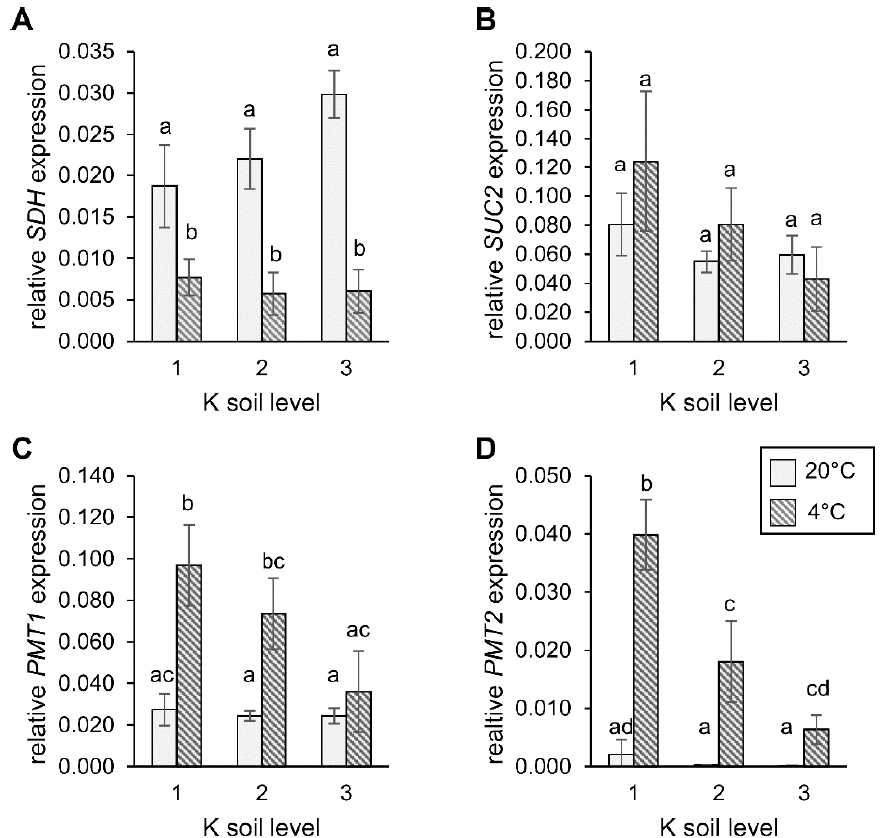
Figure 7. Effect of cold stress on the expression of sorbitol and sucrose-related genes. ( A ) Relative SDH mRNA levels, ( B ) relative SUC2 mRNA levels, ( C ) relative PMT1 mRNA levels, and ( D ) relative PMT2 mRNA levels. Bars show means from n = 6 biological replicates ± SE. Different letters above bars denote significant differences between means, according to one-way ANOVA, with post-hoc Tukey HSD testing ( p > 0.05).